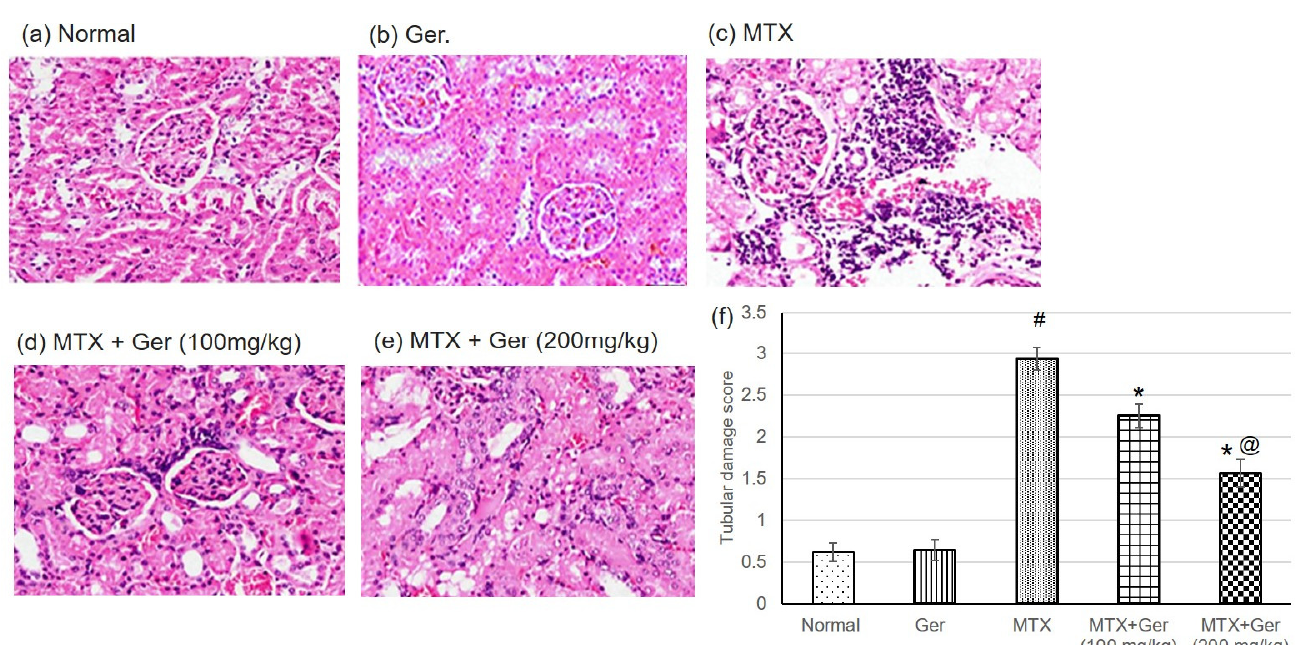
Figure 1. Effects of treatment with Ger (100 and 200 mg/kg) for 19 days on the histopathological investigation using H&E staining demonstrating normal glomeruli and renal tubules in ( a ) normal and ( b ) Ger groups, congestion of interstitial blood vessel and glomerular capillary tuft associated with intense focal renal interstitial proliferating mononuclear cell infiltration in MTX group ( c ), focal necrosis of epithelial lining associated with uniformly arranged regenerative renal tubules in Ger-administered groups ( d ) and ( e ) (H&E, × 400) and ( f ) tubular damage score, which varies from 0 for completely normal histology to 3 for maximal and widespread injury. All values are expressed as mean ± SD. #, statistically significant from normal group; *, statistically significant from MTX-only group; @, statistically significant from MTX + Ger 100 mg/kg group ( p < 0.05) using one-way ANOVA followed by Tukey’s post hoc analysis.